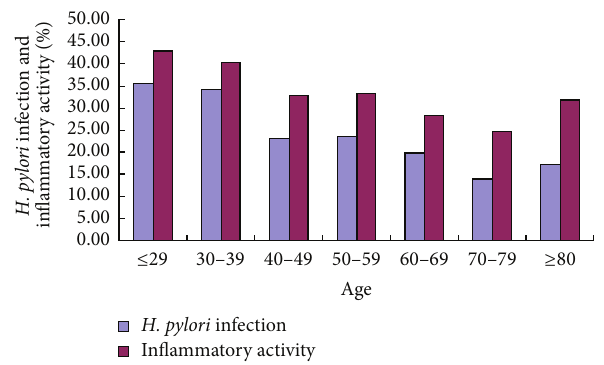
Figure 1: The percentage positivity of H. pylori infection and inflam- matory activity in 3969 cases of atrophic gastritis according to age